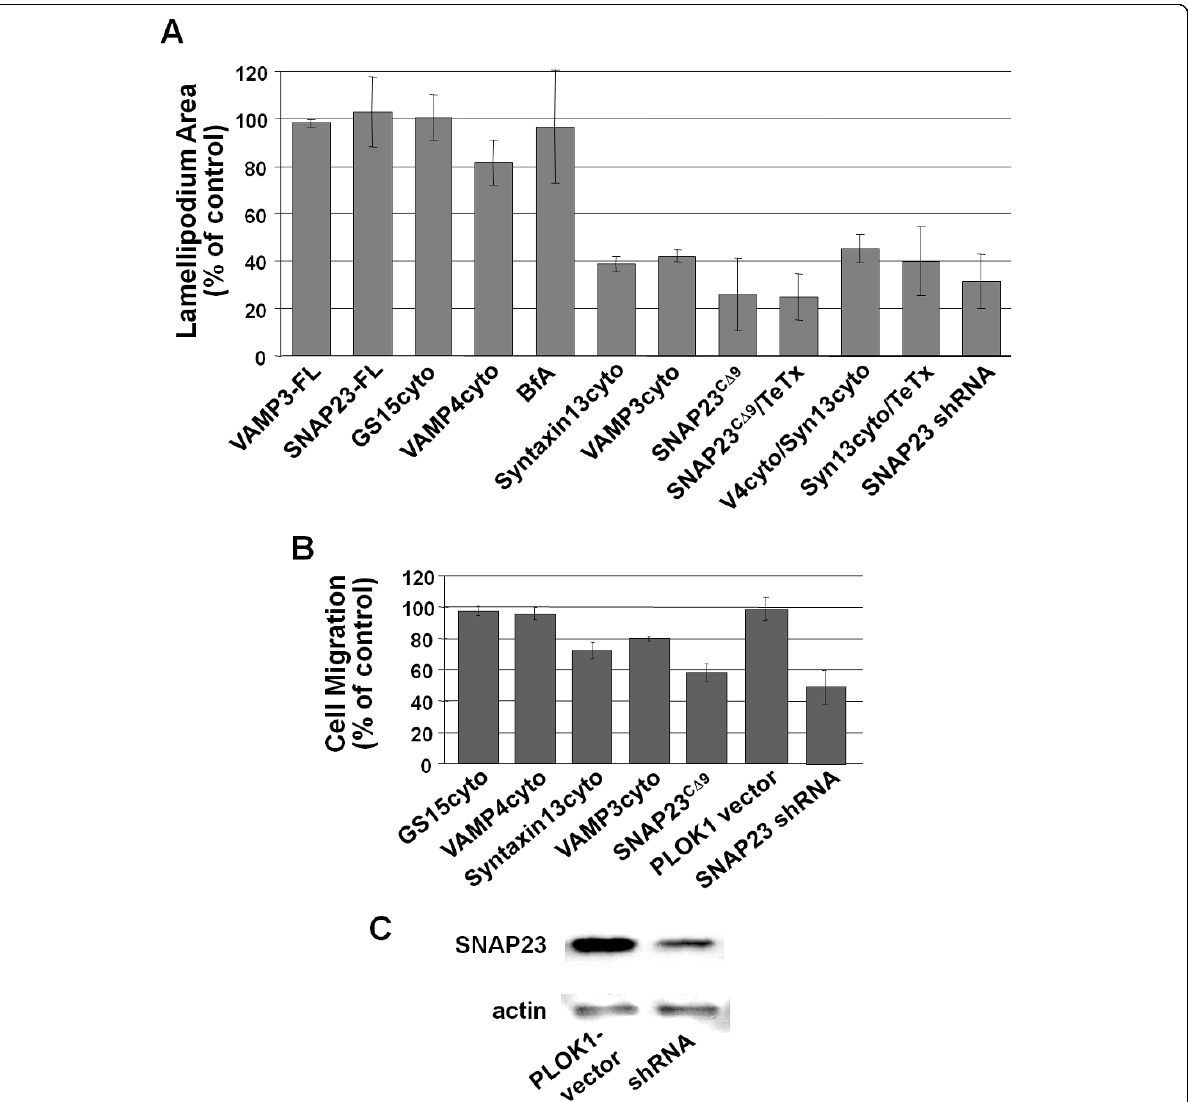
Figure 2 Dominant-negative SNARE domains impair lamellipodium extension . (A) CHO-K1 cells were transiently transfected with GFP- tagged constructs of the indicated SNAREs: GS15, VAMP4, VAMP3, syntaxin13 or SNAP23. Constructs encoded either the full length protein (FL) or the dominant-negative form (cyto; C Δ 9 in the case of SNAP23). HeLa cells were transfected with a SNAP23 shRNA construct (SNAP23 shRNA). The cells were plated on FN-coated (20 μ g/ml) coverslips and the extent of cell spreading was calculated as the increase in ventral surface area that occurred between 30 and 90 mins. The results are presented as percent of non-transfected control sample. More than 50 randomly selected transfected cells were analyzed per experiment. Means +/- SEM of at least three independent experiments are shown. (B) CHO cells were transfected as above, serum starved for 3 hrs and placed into a transwell chamber containing polycarbonate membranes coated on the underside with FN. Cells were allowed to migrate for 4.5 h, the membranes were fixed and the percentage of transfected cells migrated was assessed. Data is presented as the percentage of transfected cells migrated normalized to full-length controls and represent at least three independent experiments. (C) A sample of the same HeLa cells used in (A) were lysed and analyzed by Western blot for knockdown of SNAP23 expression. Actin served as a loading control. A set of representative blots are